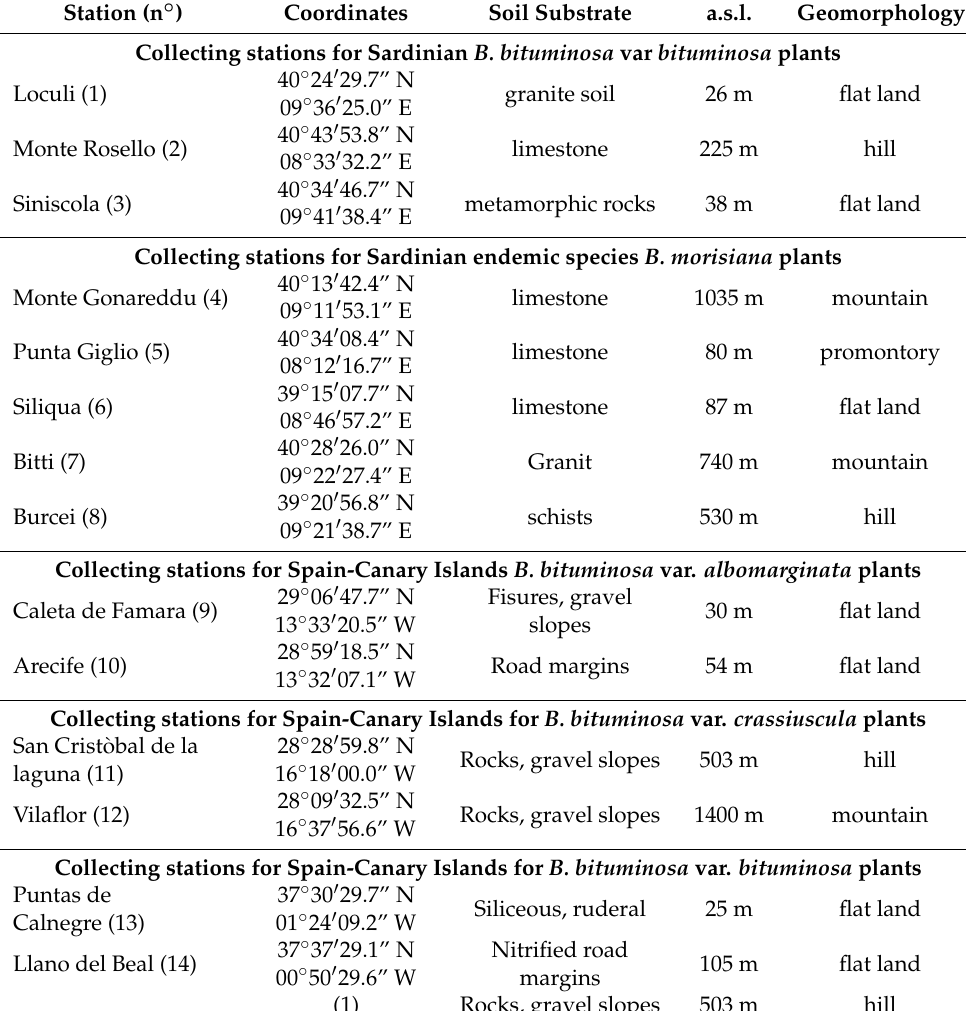
Table 4. Collecting stations for accessions of Sardinian and Spanish B. bituminosa (and its varieties) and endemic B. morisiana plants. Station (n ◦ ) Coordinates Soil Substrate a.s.l.